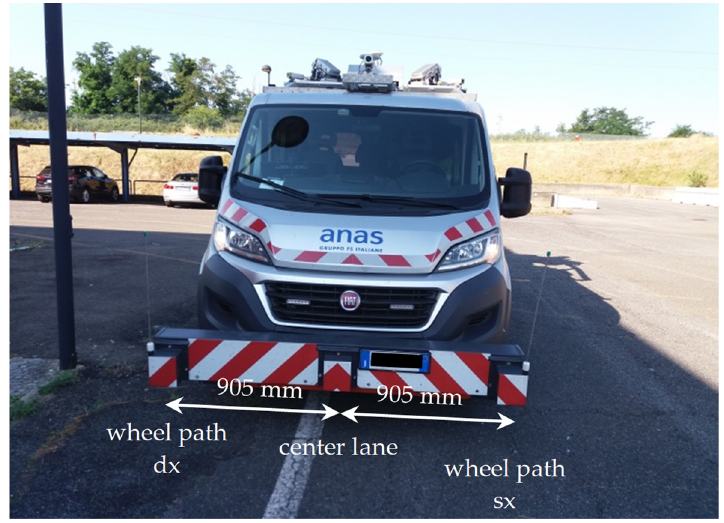
Figure 7. “ Cartesio” front view; the RSPs are assembled on a bar in front of the vehicle. Figure 7. “Cartesio” front view; the RSPs are assembled on a bar in front of the vehicle.